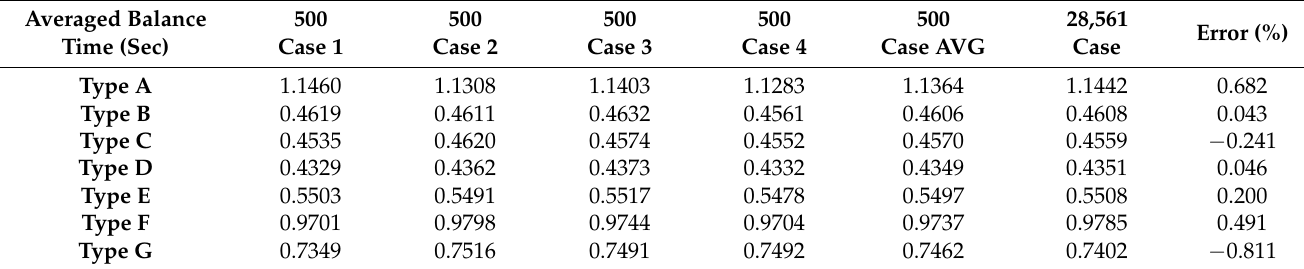
Table 4. Average balancing times of the 4 battery cells using different SC-based